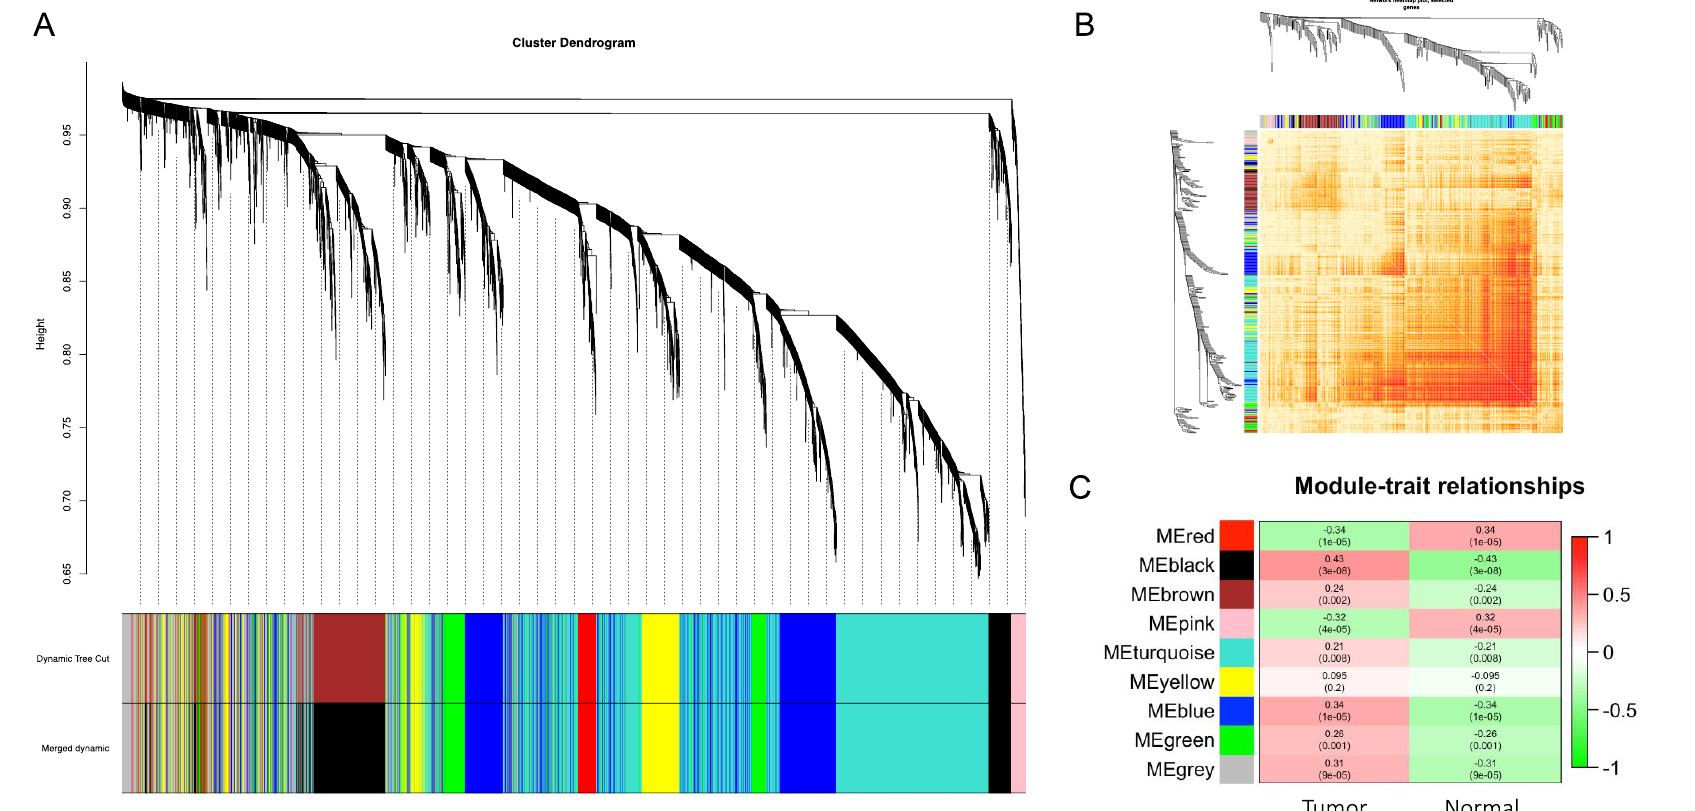
Figure 4. Weighted gene co-expression network. ( A ) Gene dendrogram obtained by average linkage hierarchical clustering. The color row underneath the dendrogram shows the module assignment determined by the Dynamic Tree Cut. ( B ) Network heatmap plot. Branches correspond to modules in the hierarchical clustering dendrograms. Darker color indicates higher co-expression and interconnection. ( C ) Module–trait relationships. X-axis: clinical trait of tumor or normal. Y-axis: clustered modules. The correlation and p -values are labeled in each block.